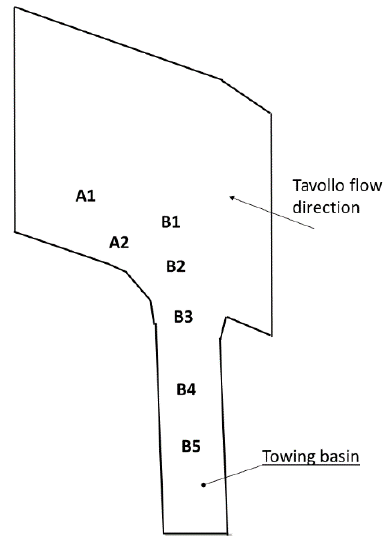
Figure 7. Position of the selected bathymetries measuring points for the evaluation of ejectors discharge impact.